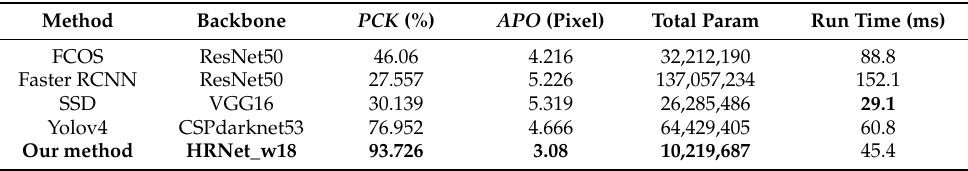
Table 4. Comparison with state-of-the-art object detection